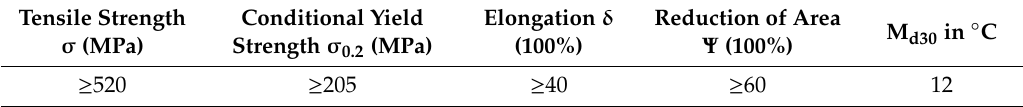
Table 3. Physical properties of corundum particles. Table 2. Basic properties of 304 stainless steel used in this study.